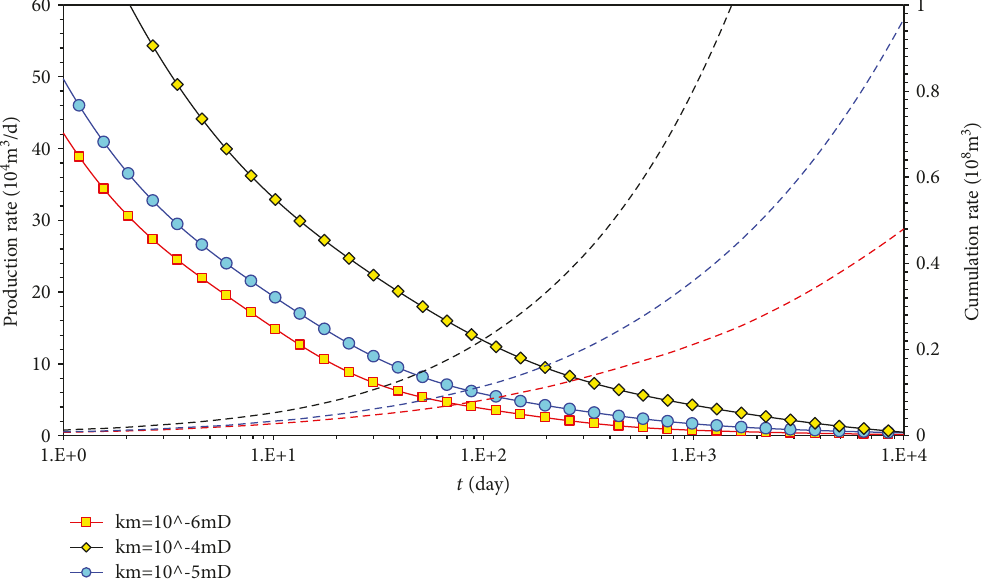
Figure 11: In fl uence of permeability in macropore system on well production performance.